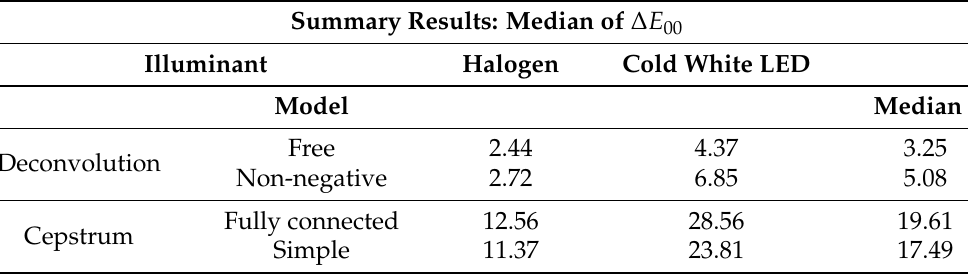
Table 4. Summary results of the median of ∆ E 00 between estimated and ground truth spectra for illuminant, method, and model combinations, median over